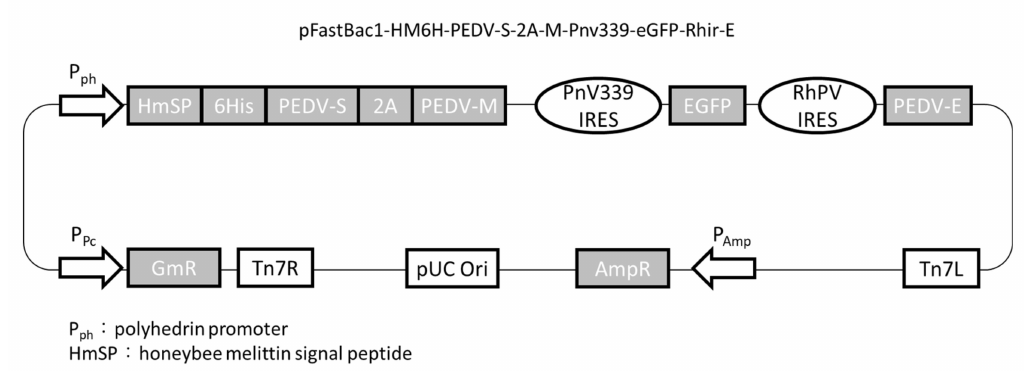
Figure 1. The construction map of the plasmid pFastBac1- HM6H- PEDV- S- 2A- M- Pnv339- eGFP- Rhir-E. The recombinant Taiwan G2b PEDV-PT strain spike (S) gene, with the honey bee melittin signal peptide and 6xHis-tag, and the membrane (M) gene linked by the 2A-like sequence were driven by the polyhedrin promoter. The envelope (E) gene was translated through the internal ribosome entry site (IRES) of Rhopalosiphum padi virus (RhPV). Enhanced green fluorescent protein (EGFP) gene was inserted into the plasmid and expressed by a truncated perina nuda picorna-like virus IRES (PnV339